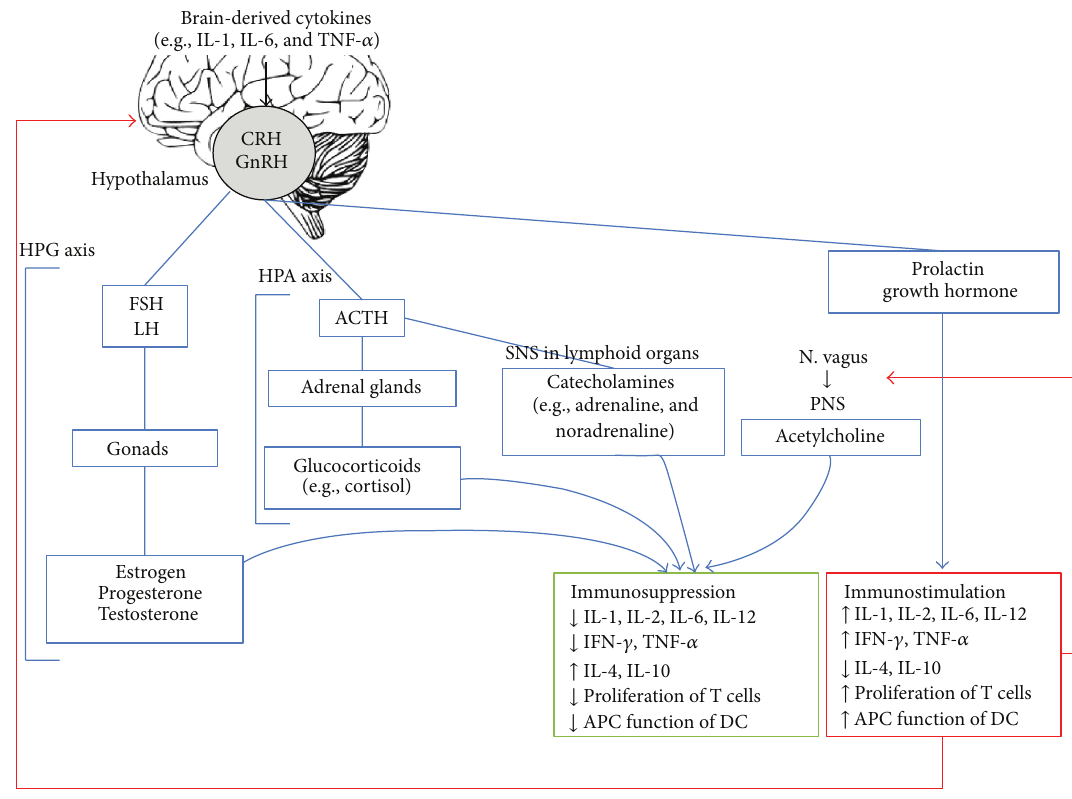
Figure 1: The neuroendocrine-immune system. Via a complex system of common messenger molecules and receptors, the neuroendocrine and the immune systems bidirectionally communicate and monitor each other’s activities. Integration of these signals is essential to maintain homeostasis and health and may result in immunosuppression or immunostimulation. Discrepancies at any level can lead to changes in susceptibility to and severity of several autoimmune and inflammatory